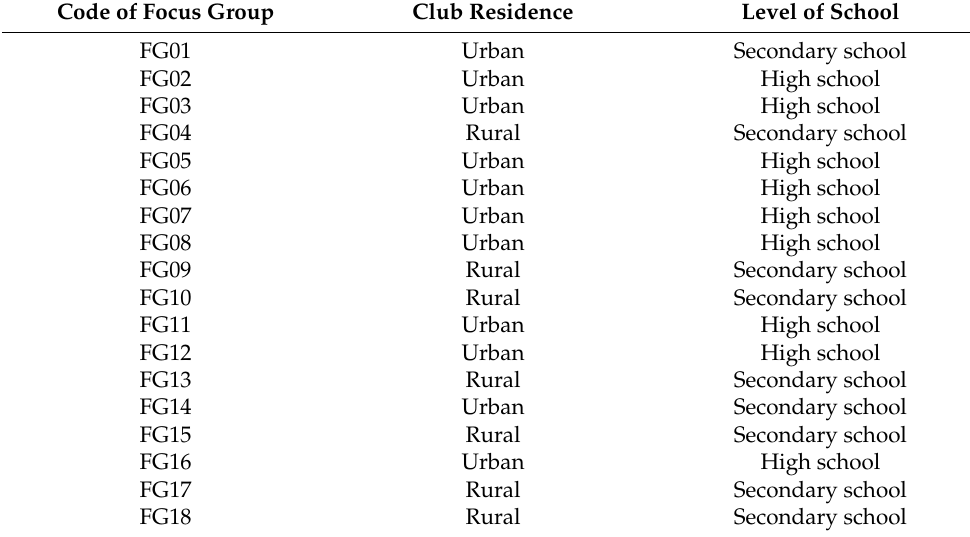
Table 4. Characteristics of focus group